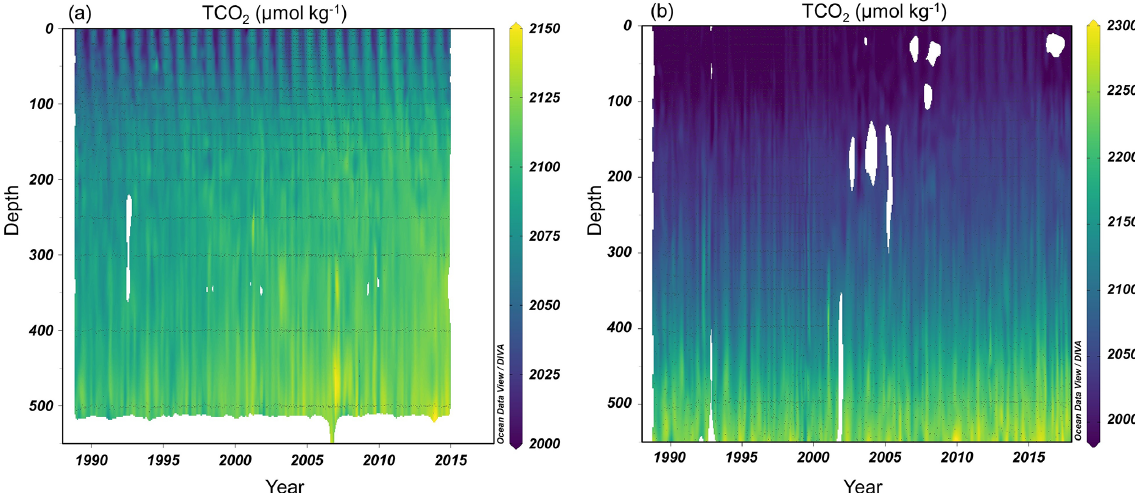
Figure 6. Time series of TCO 2 using NNGv2LDEO at (a) BATS and (b) HOT ALOHA locations. The water column shows a higher concentration of TCO 2 year by year. This figure was made with Ocean Data View (Schlitzer,